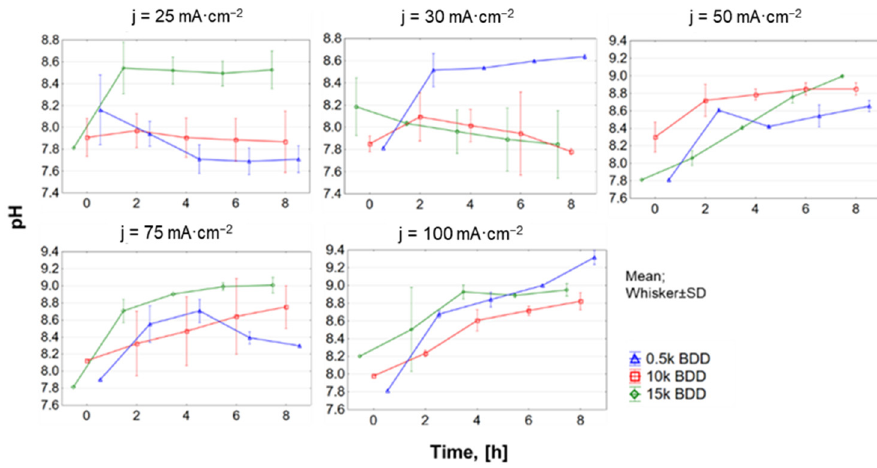
Figure A4. pH changes in LLs with different BDD anodes and current densities (25–100 mA · cm − 2 ).